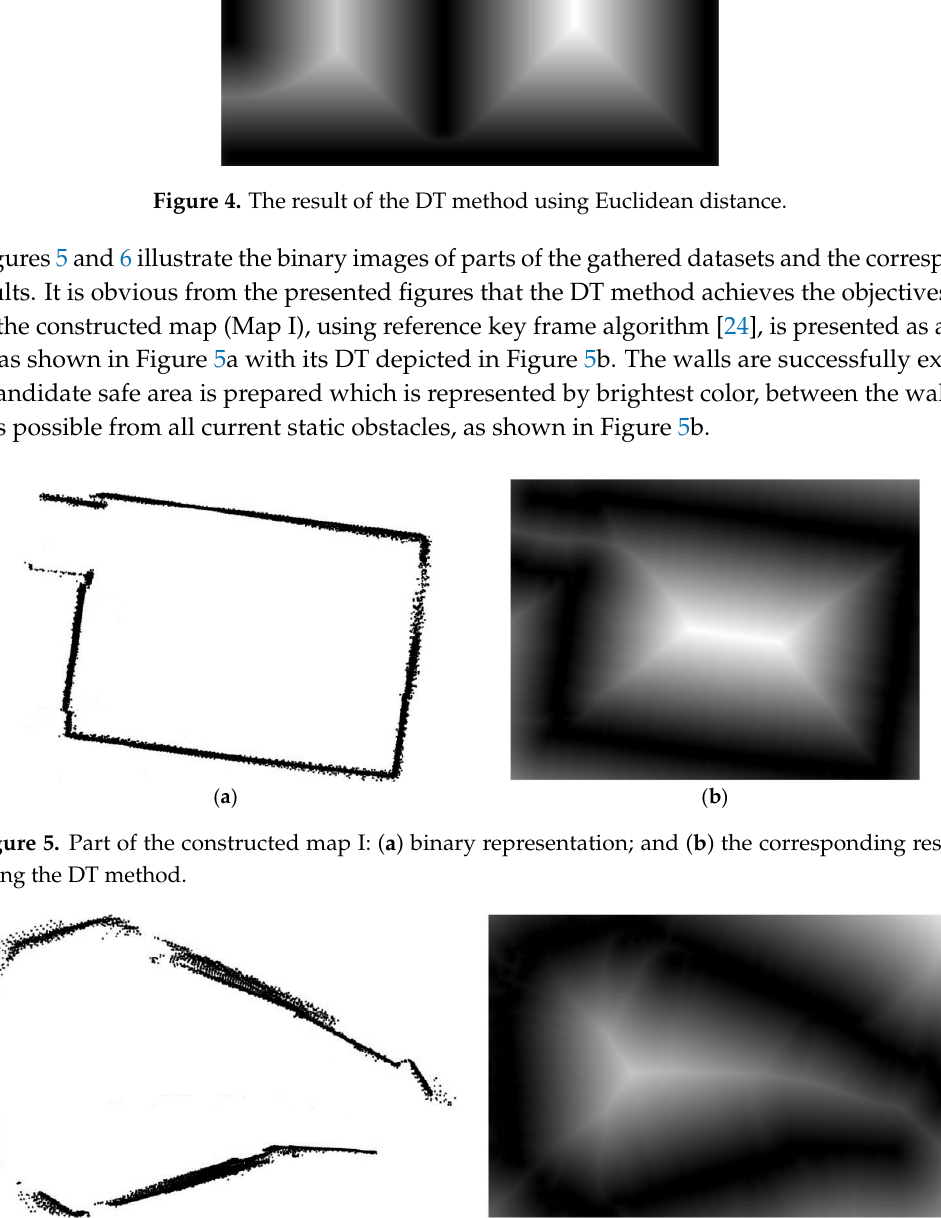
Figure 4. The result of the DT method using Euclidean distance.